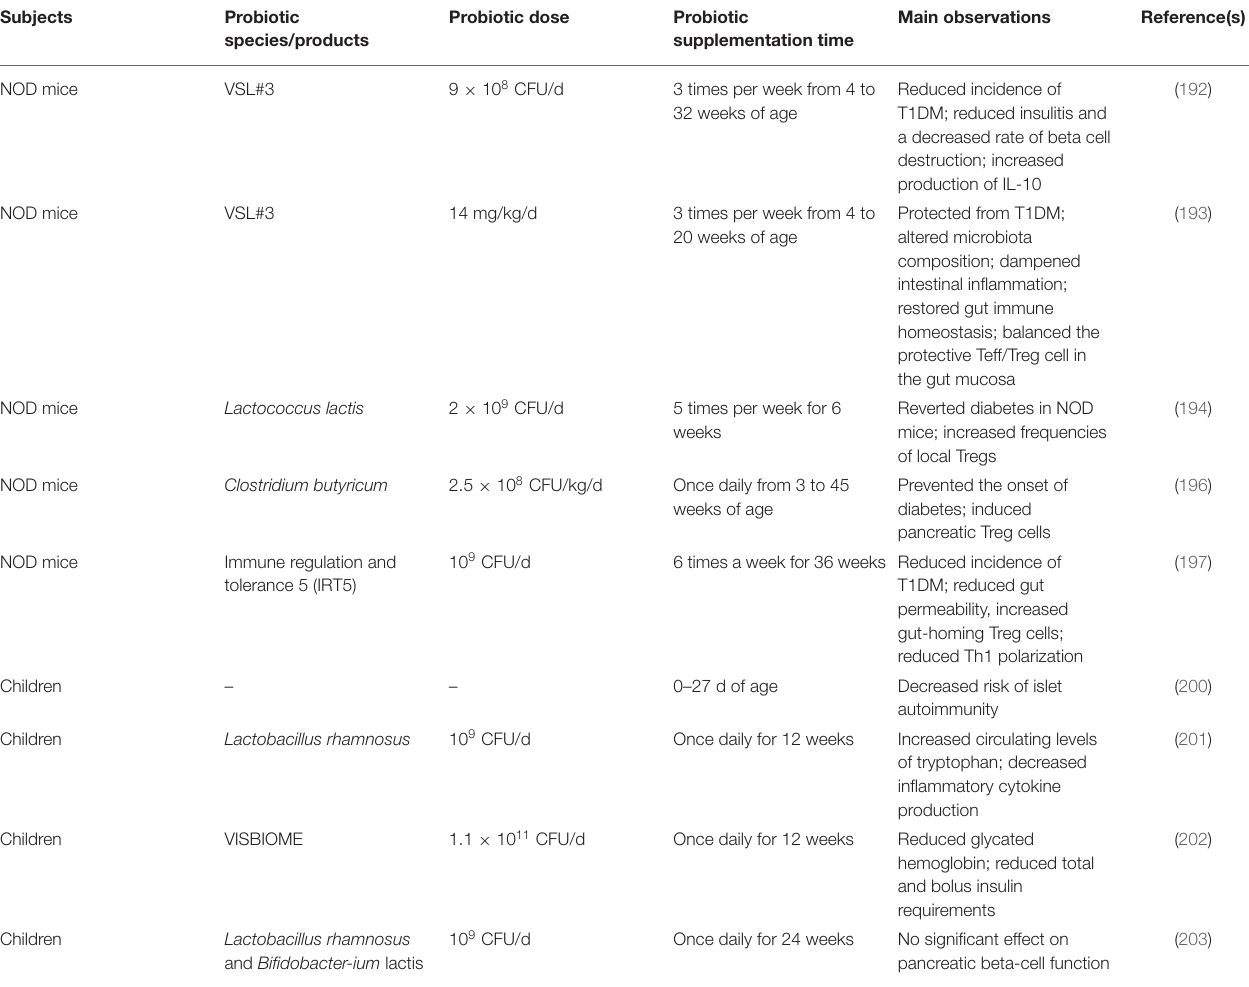
TABLE 3 | Studies investigating the efficacy of probiotics in preventing and alleviating murine and human type 1 diabetes mellitus